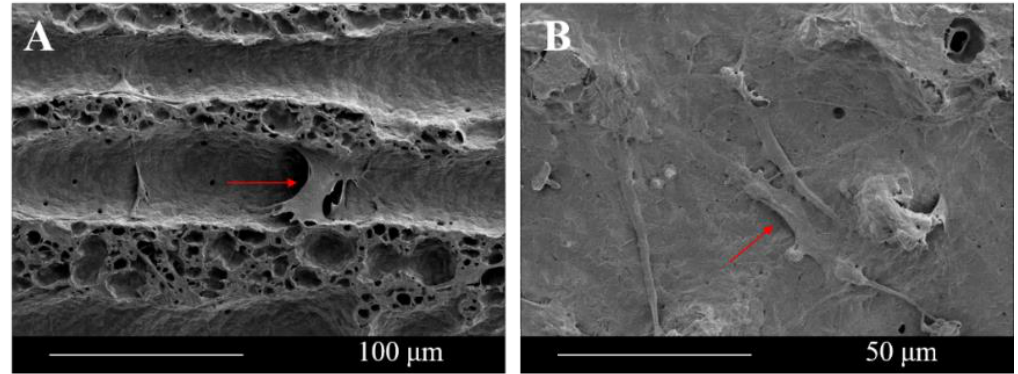
Figure 9. SEM images of cells (red arrow shows) seeded on fibers fabricated at Z = 4 mm: ( A ) cross the bump, ( B ) cling on the surface.